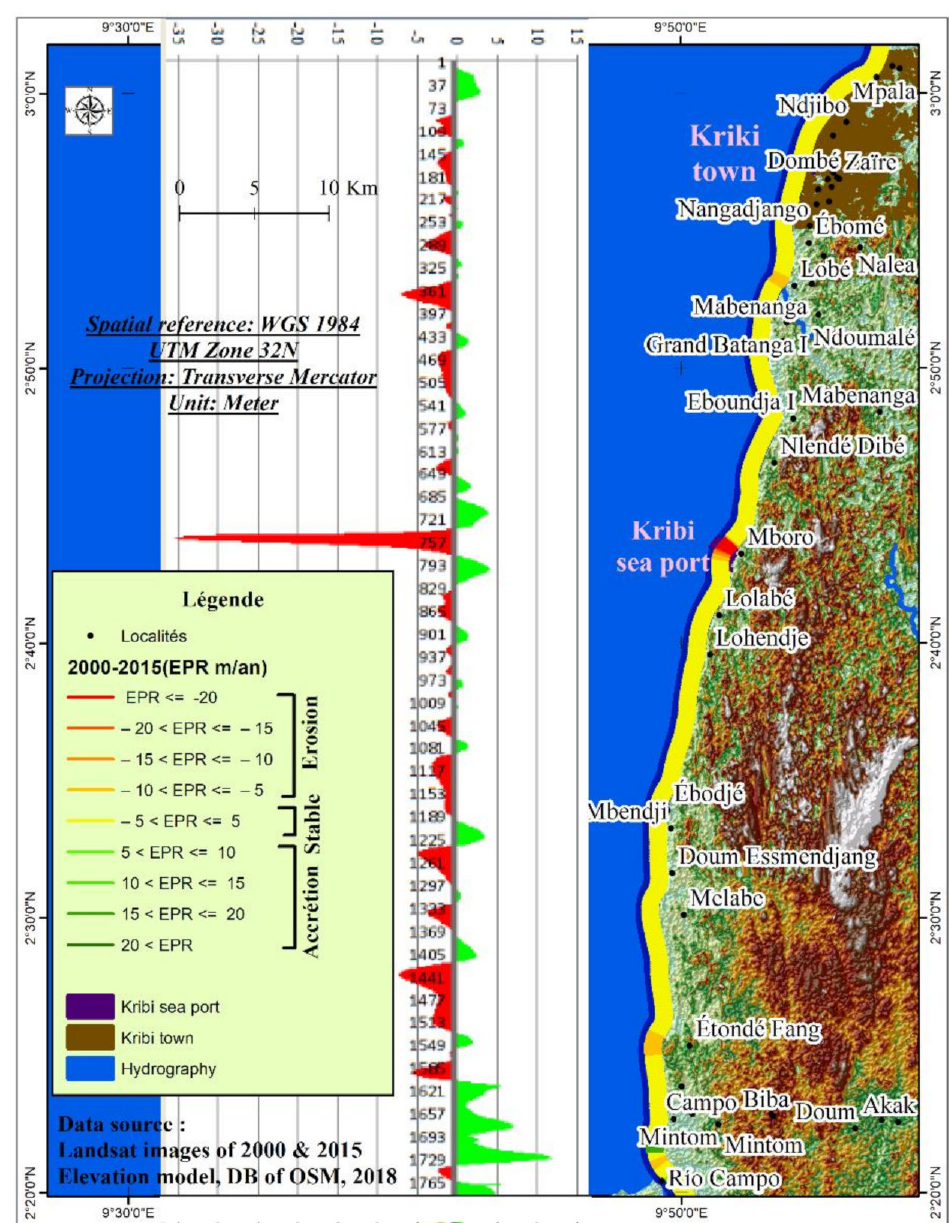
Figure 15. Coastal erosion on the Kribi coast in EPR (m/year) between 2000 and 2015 obtained with DSAS, through linear data extracted from Landsat